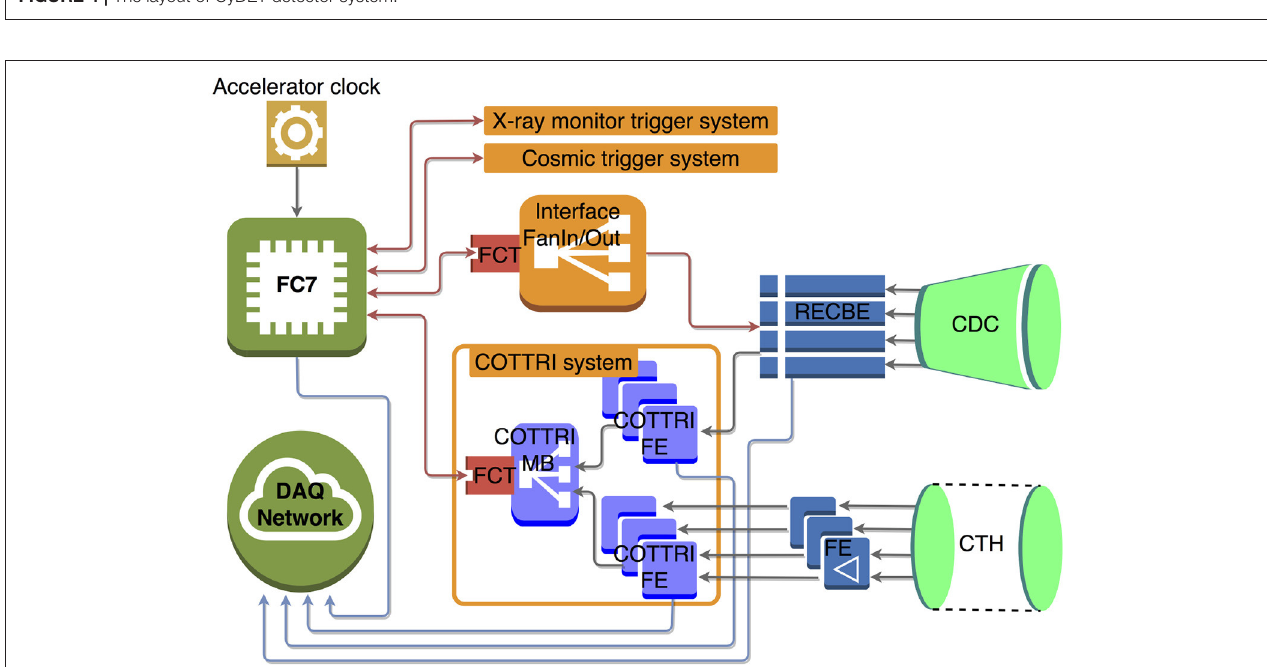
FIGURE 4 | The layout of CyDET detector system.